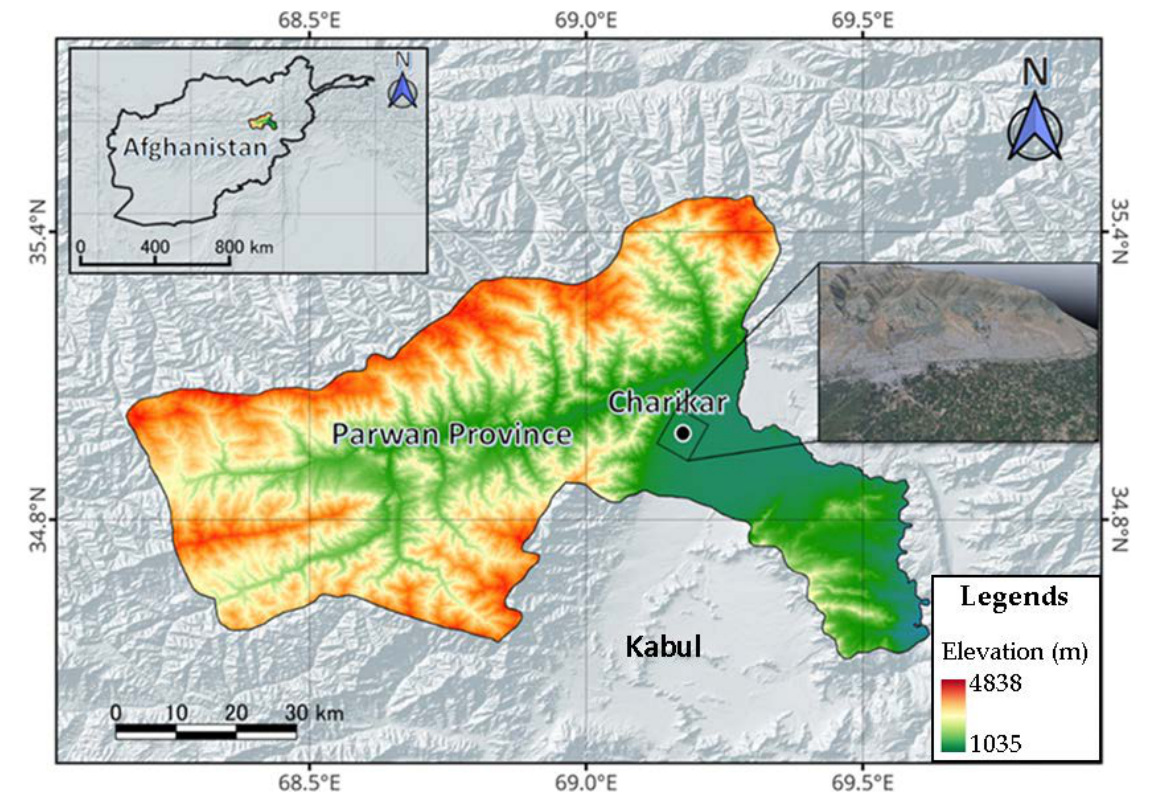
Figure 1. Topographical map of the study area showing how Charikar city is surrounded by high mountains of Hindu Kush which the elevation is between 1000–4000 m.